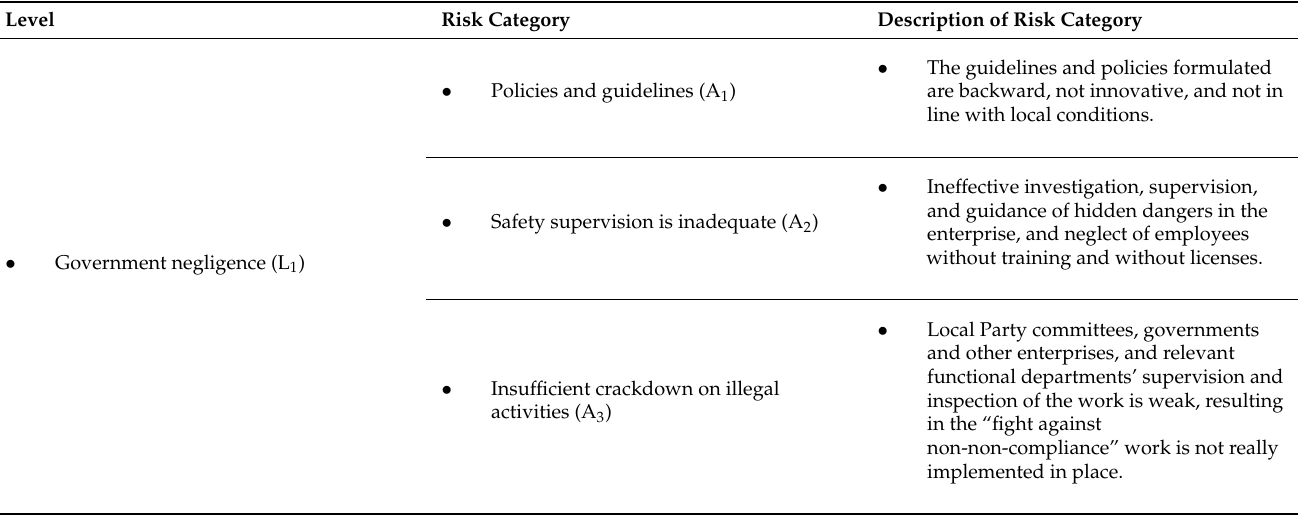
Table 1. Classification categories of risk